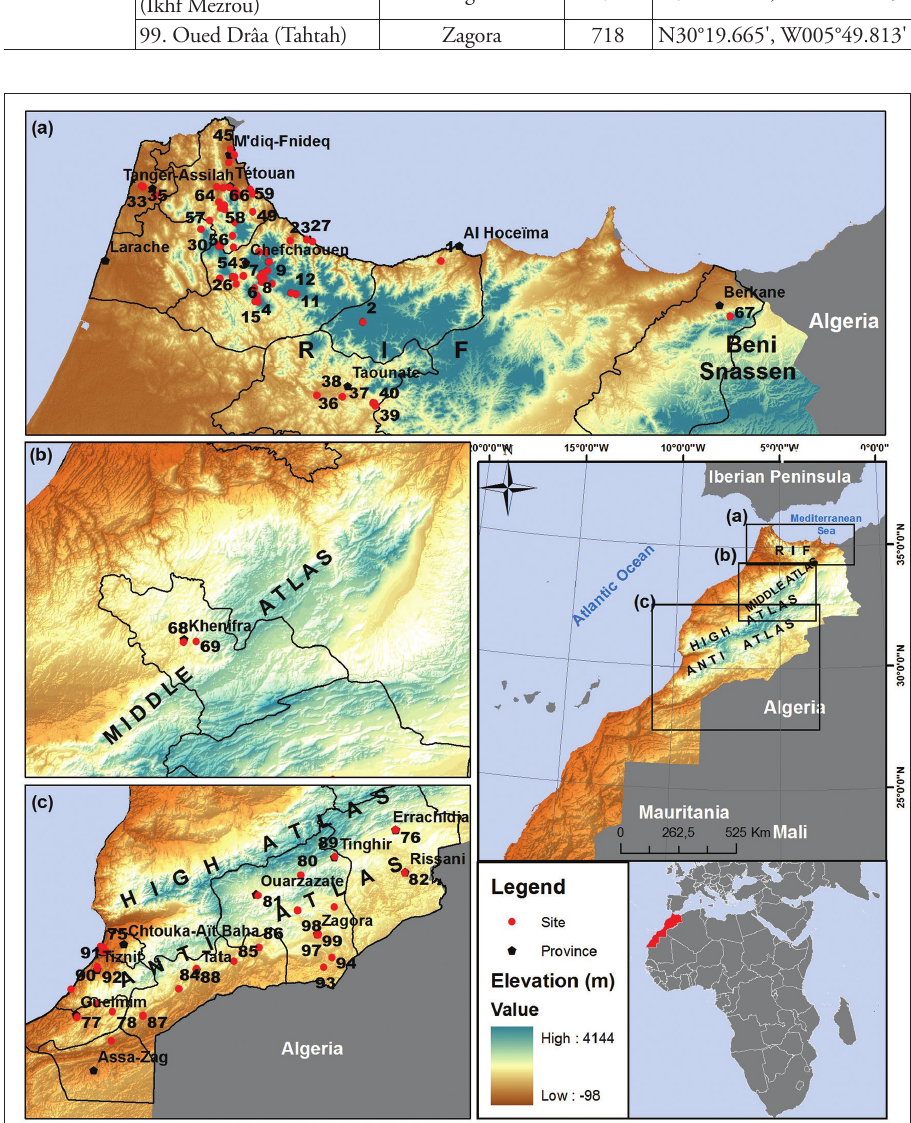
Map 1. Map showing all collecting sites in